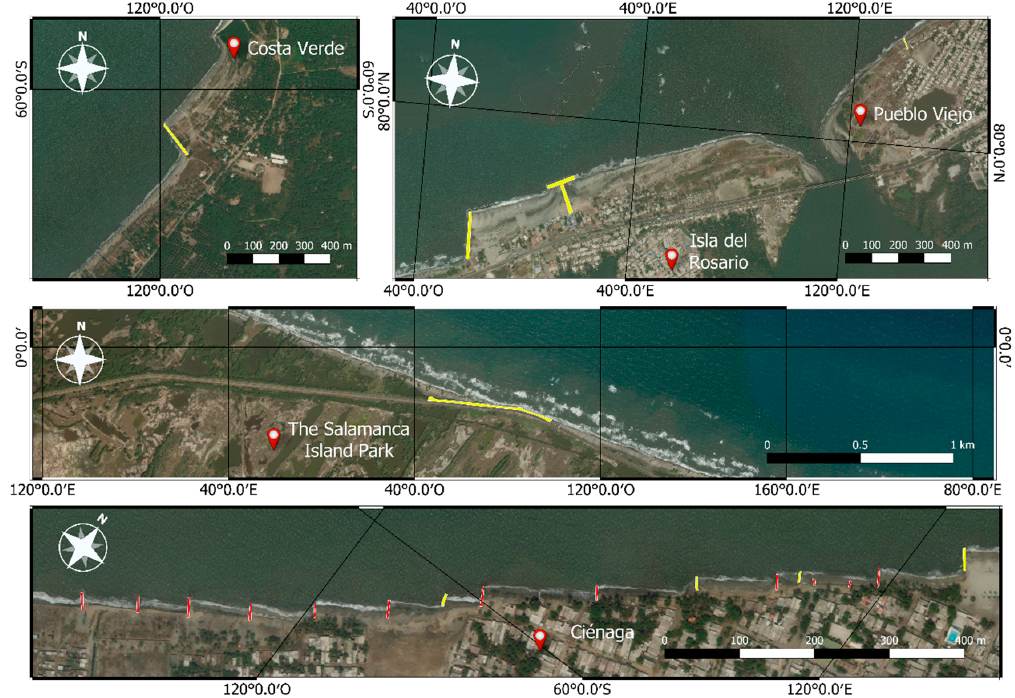
Figure 9 . Coastal structures in the CGSM littoral cell. Failed structures are shown in red. Operative structures are shown in yellow. structures are shown in